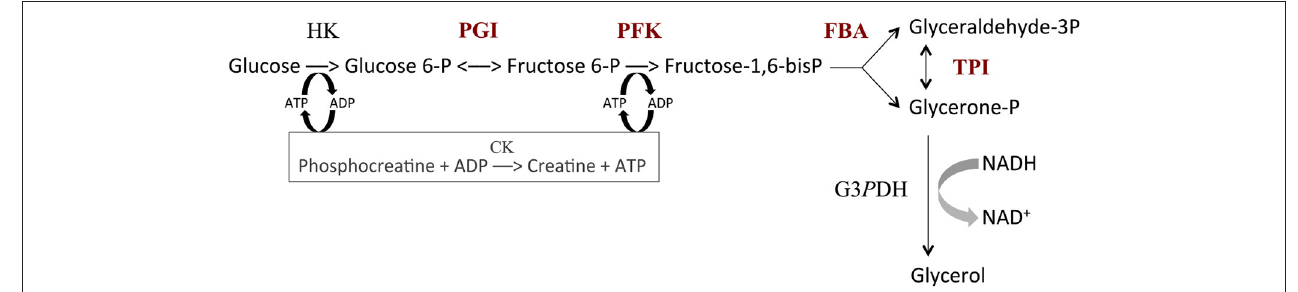
FIGURE 2 | The upstream part of glycolysis reconstructed in vitro . HK, hexokinase (E.C. 2.7.1.1); PGI, phosphoglucose isomerase (E.C. 5.3.1.9); PFK, phosphofructokinase (E.C. 2.7.1.11); FBA, fructose-1,6-bisphosphate aldolase (E.C. 4.1.2.13); TPI, triosephosphate isomerase (E.C. 5.3.1.1); G3 P DH, glycerol 3-phosphate dehydrogenase (E.C. 1.1.1.8); CK, creatine phosphokinase (E.C. 2.7.3.2). Variable enzymes are in red. Reaction rate was measured from the decrease in NADH concentration.